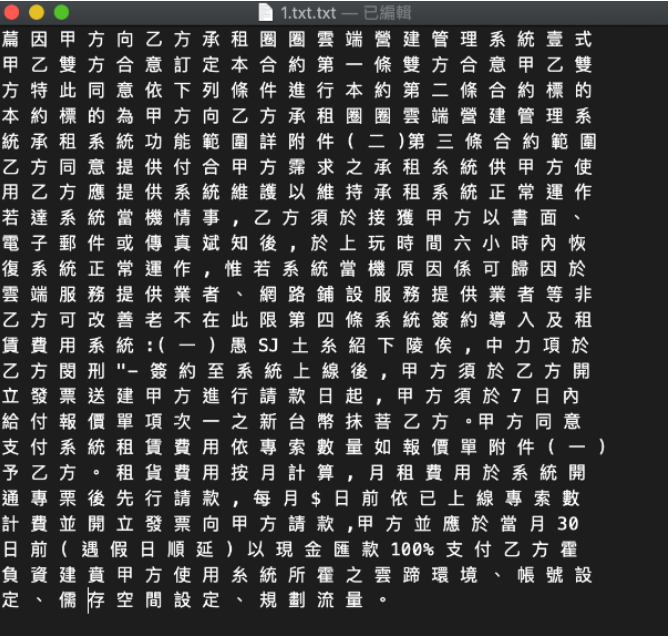
Figure 5. Illustration for text identification (The text identification listing all possible key Chinese characters from the recognition on Figure 4).